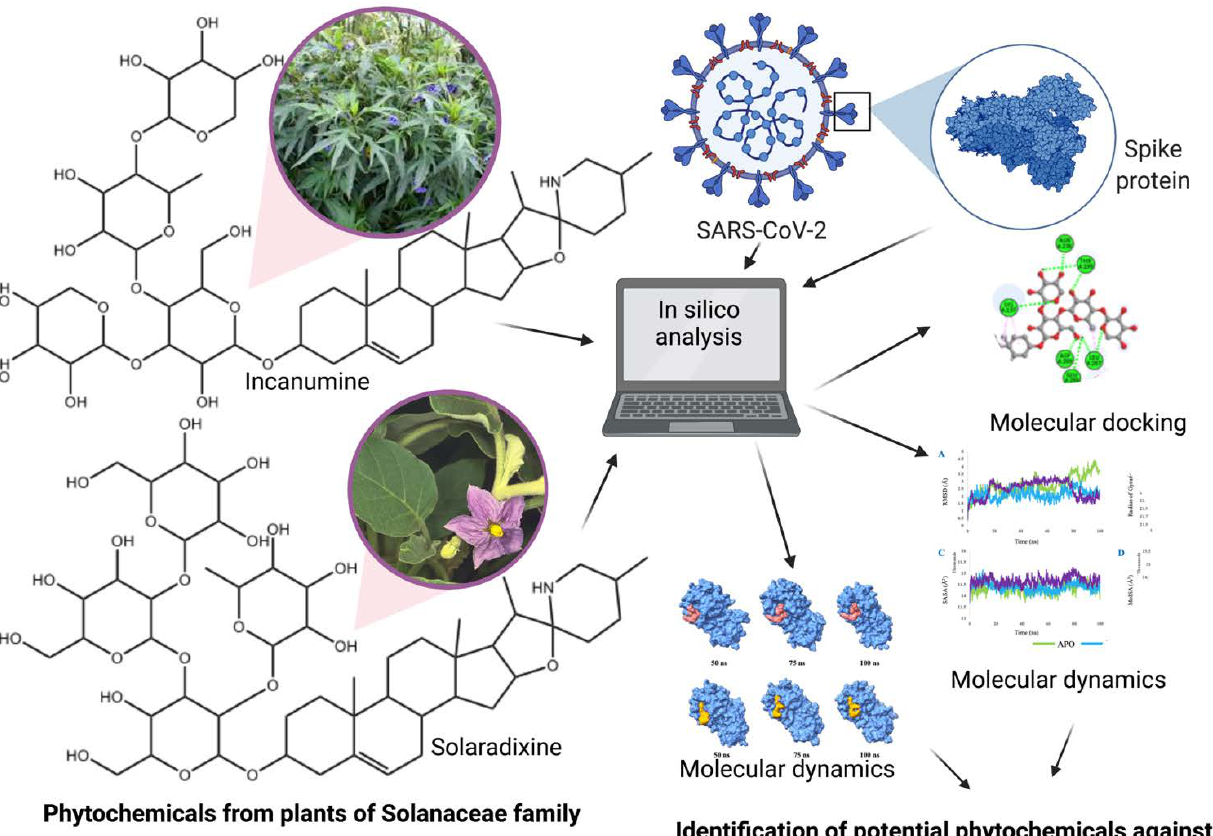
Figure 11 . Identification of potential compounds against SARS - CoV - 2 using in silico studies . Figure 11. Identification of potential compounds against SARS-CoV-2 using in silico